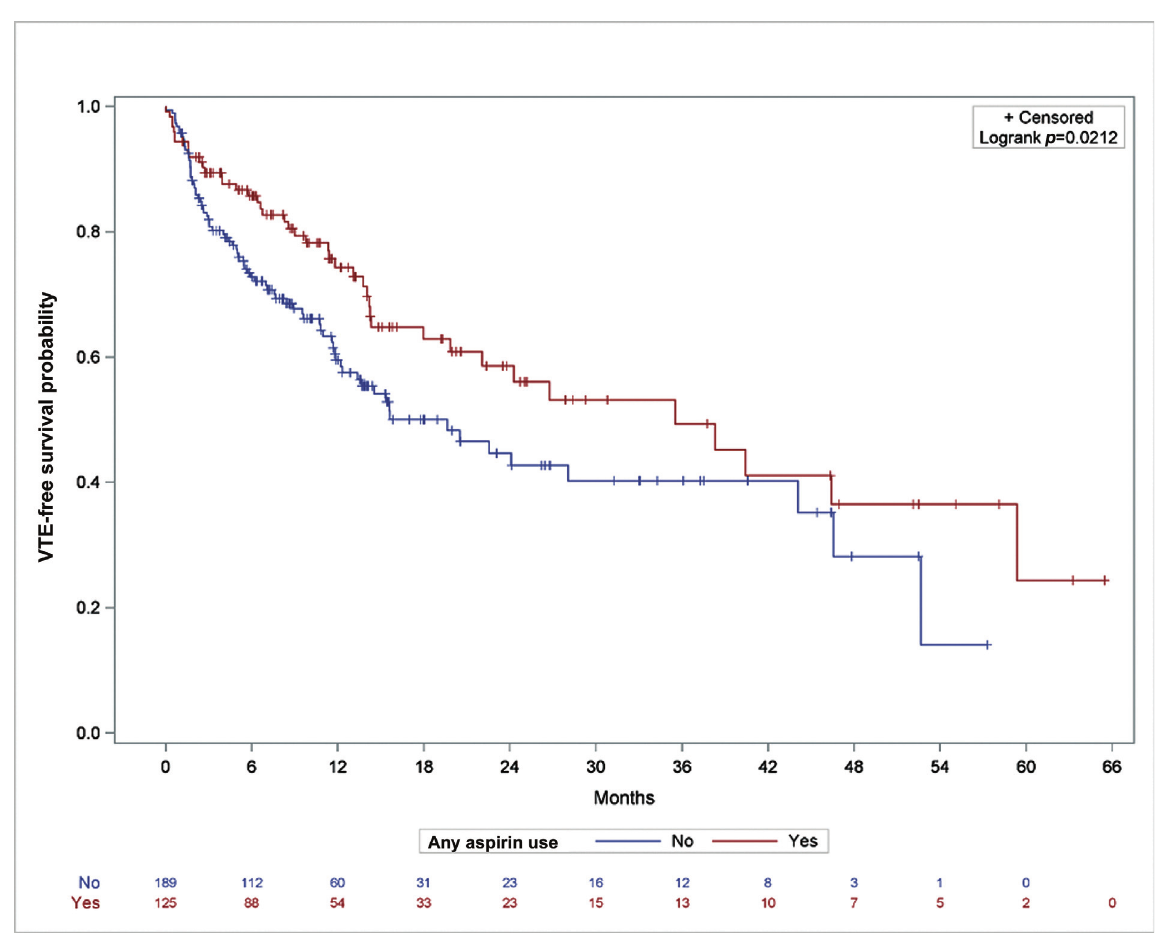
Fig. 2 Time-to-VTE event analysis for patients with aspirin (red line) or without aspirin (blue line) use. The number of patients at risk is indicated along the bottom. VTE, venous